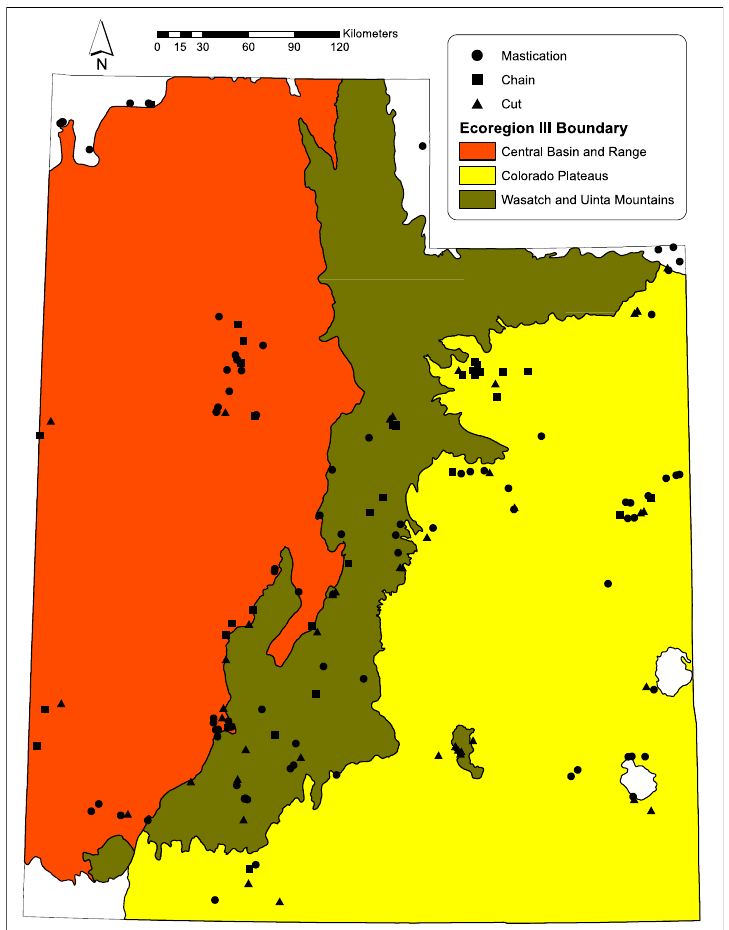
Figure 7. Map of pinyon–juniper reduction study sites in Utah.